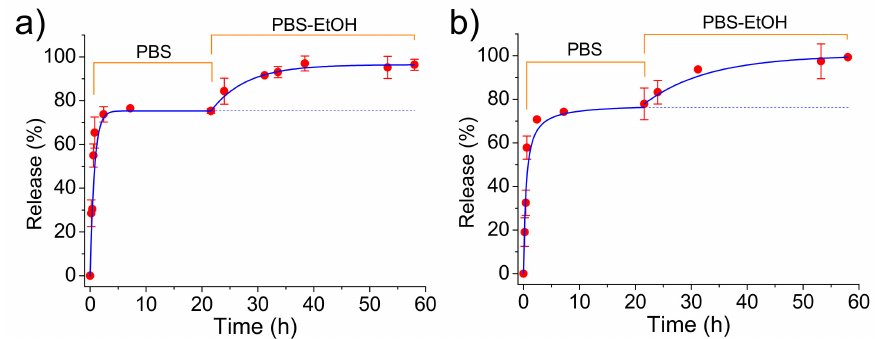
Figure 7. Release of CAM from ACP ( a ) and cHAp ( b ) loaded nanoparticles during exposure to the indicated media. PBS-EtOH refers to the PBS-ethanol mixture (see Methods